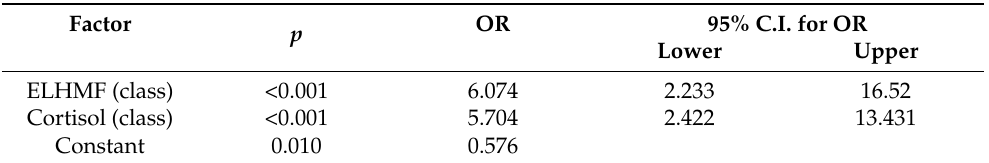
Table 4. Analysis of 64 cows with signs of lameness and 56 healthy cows (with an average of 2.8 lactations and 60 days of the postpartum period) revealed all milk electrical conductivity indicators were associated with the occurrence of cow lameness.